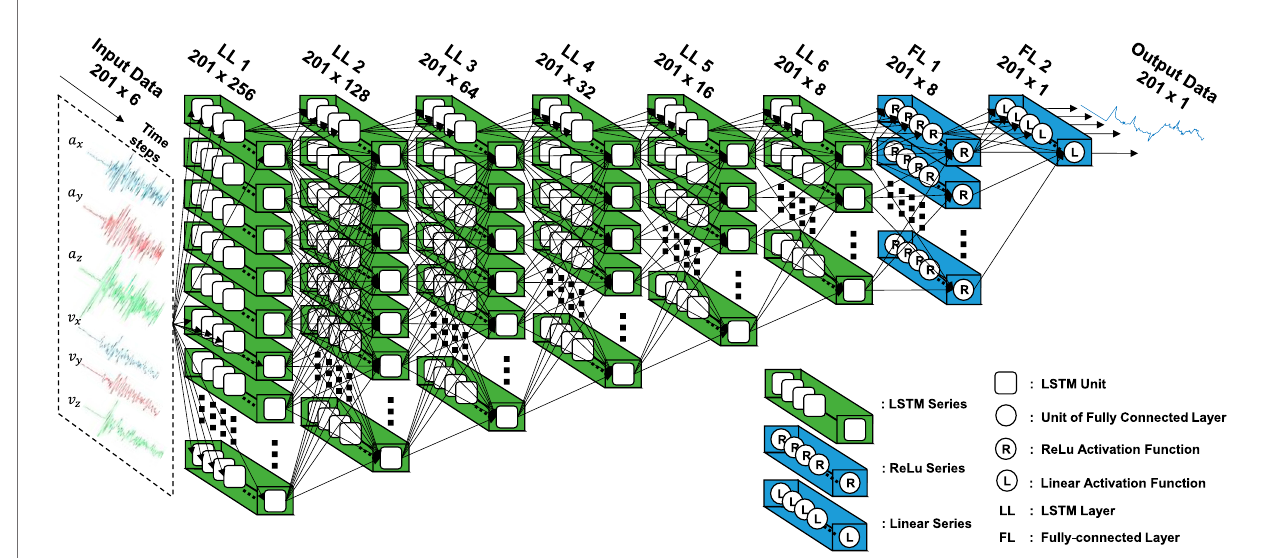
FIGURE4| ProposedarchitectureoftheLSTMmodel.LL1isthe1stLSTMLayer;LL2isthe2ndLSTMLayerandsoon;FL1isthe1stFully-connectedLayer;FL 2 is the 2nd Fully-connected Layer.